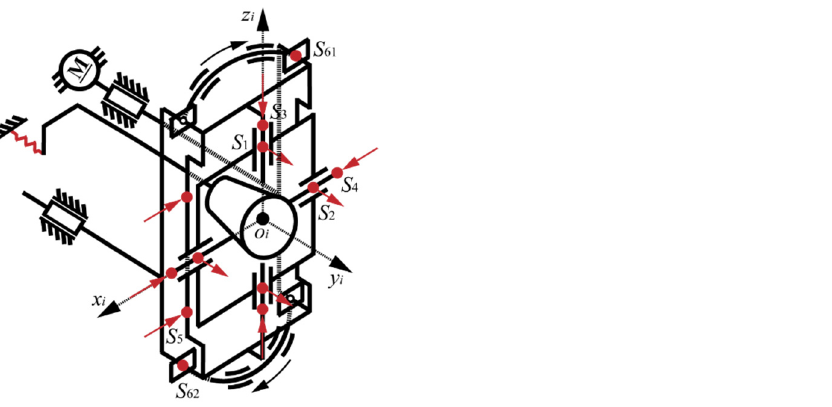
Figure 9. Kinematic diagram of the docking mechanism. The red arrows and the red points represent the preloading spring forces and the points at the corresponding spring pins acted on the drogue, respectively; the 3D model and the principles of the mechanism can be seen in Figures 4 and 5.